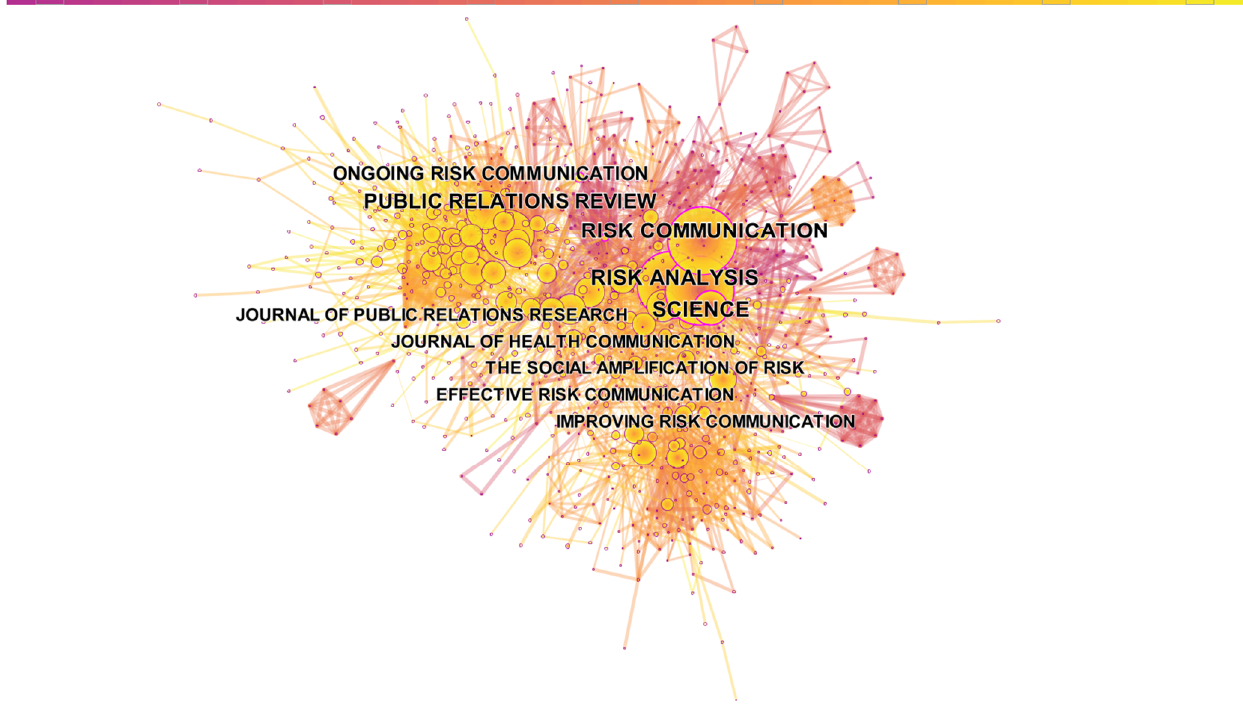
Figure 7. Map of the journal co-citation network of crisis and risk communication research.